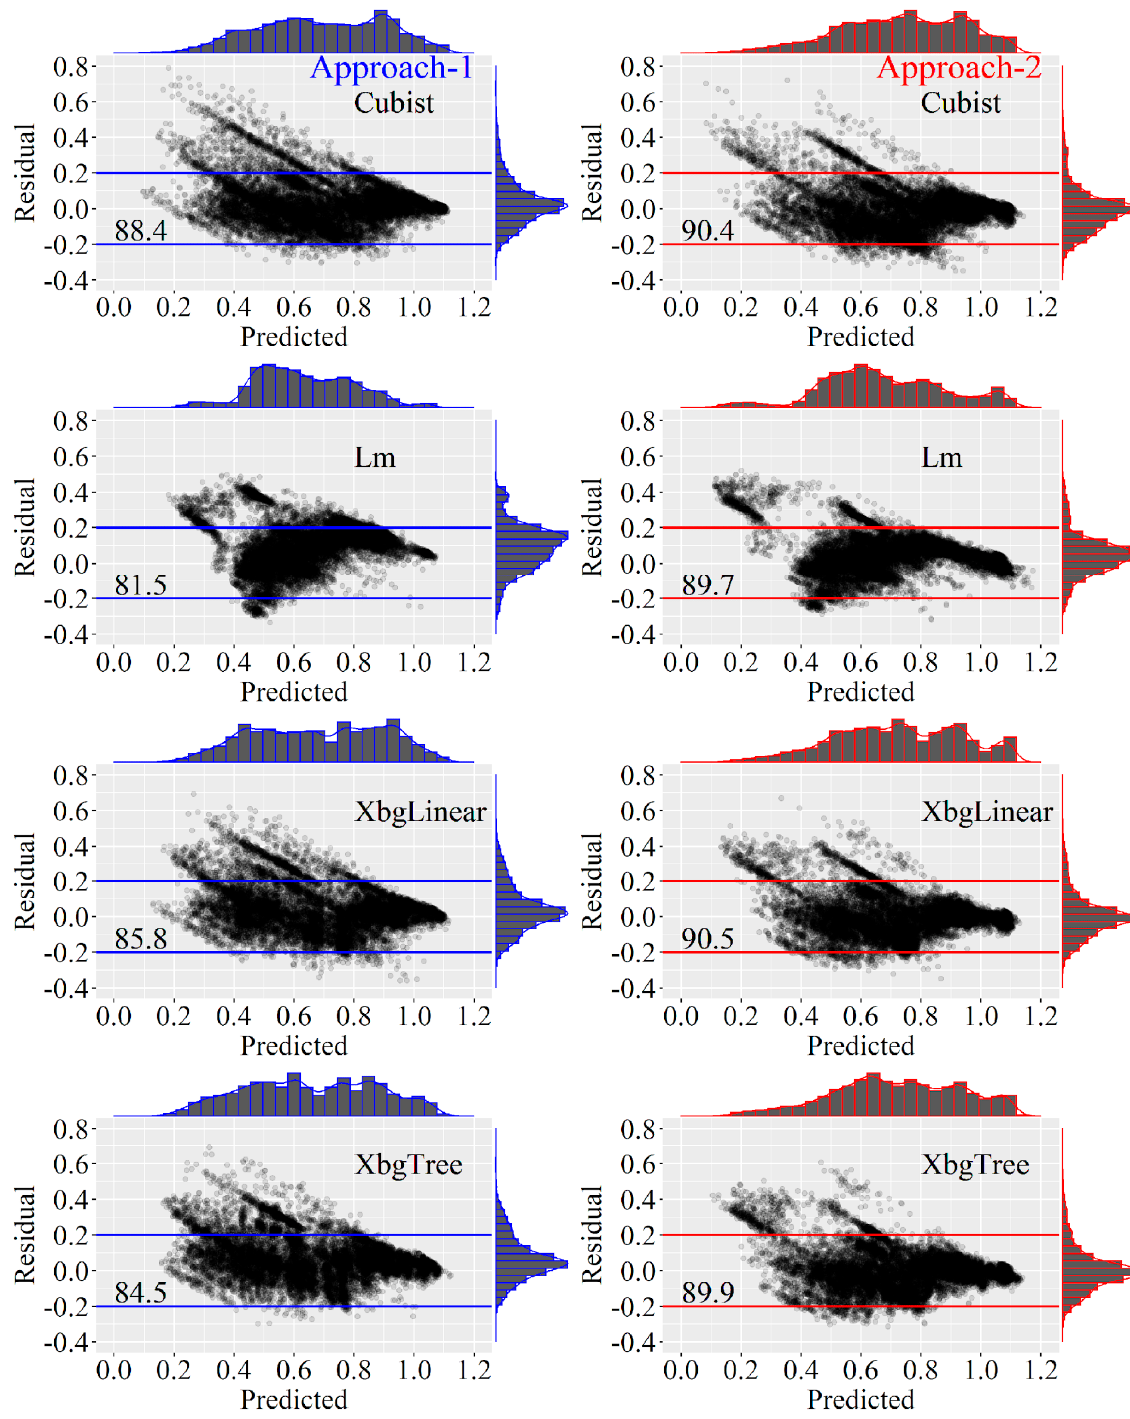
Figure 8. Residual analysis of the estimated ET r F through machine learning models.